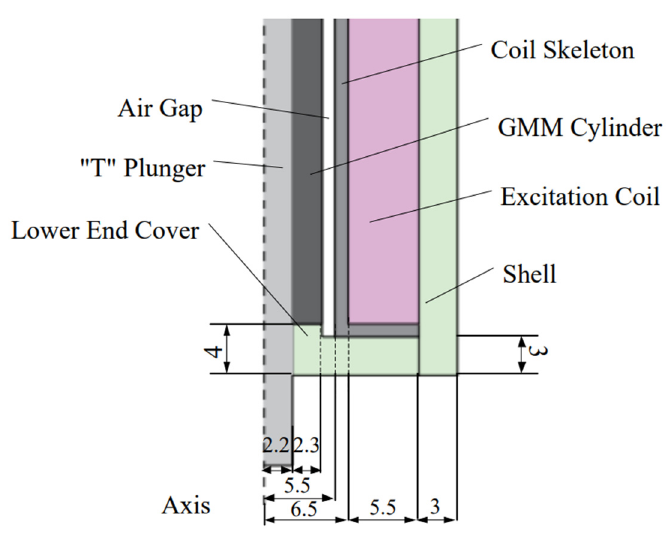
Figure 2. Dimensions of some components of the actuator.